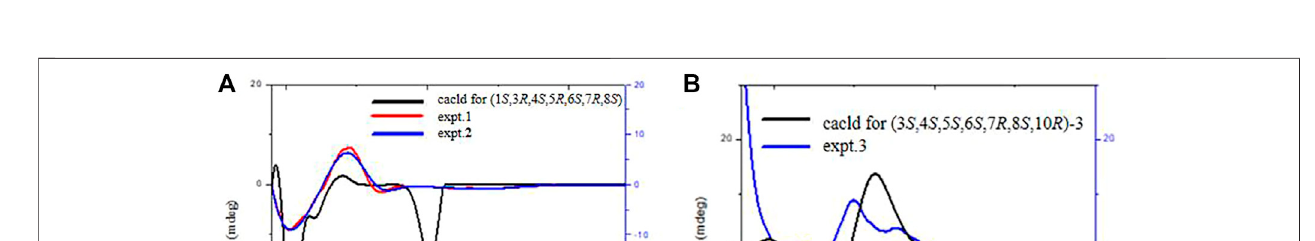
Frontiers in Chemistry |